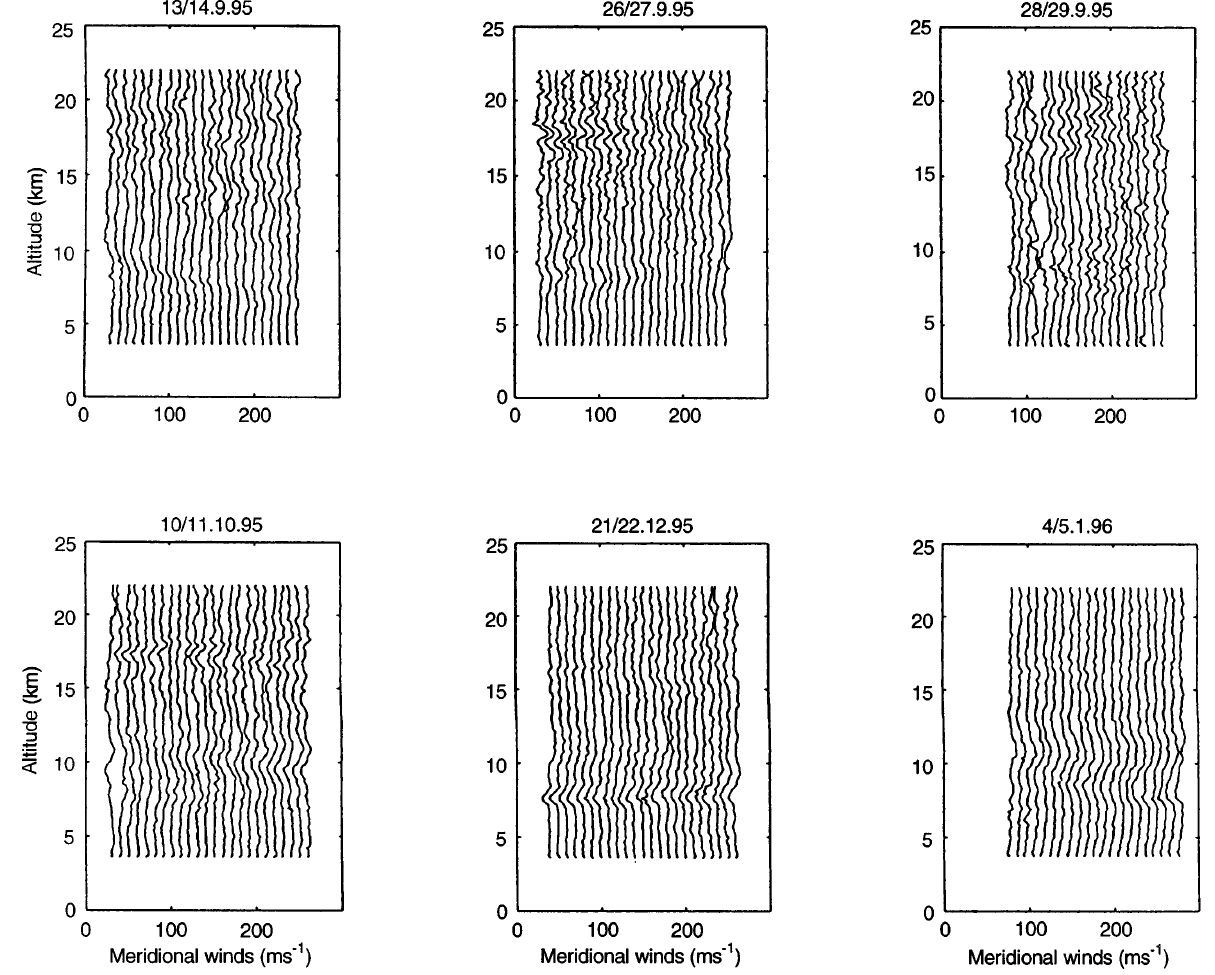
Fig. 2. Same as Fig. 1, but for northward winds. Successive profiles are displaced by 10 ms )